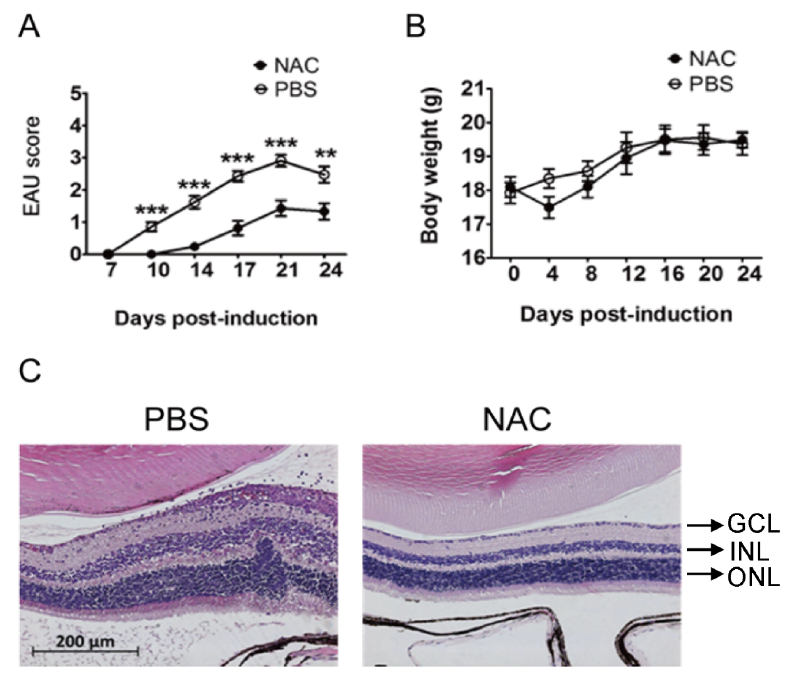
Figure 5. NAC treatment reduces EAU severity in mice. Disease scores ( A ) and body weights ( B ) of wild-type mice with EAU induction and treated with PBS ( n = 21) or NAC ( n = 21) are shown. Data show the mean ± SE values (error bars). ** p < 0.005, *** p < 0.001 compared with the NAC treatment group at the same time point. ( C ) Eyes of mice described above were subjected to staining. The retinal portion is shown. Images are representative of at least four samples per group from two independent